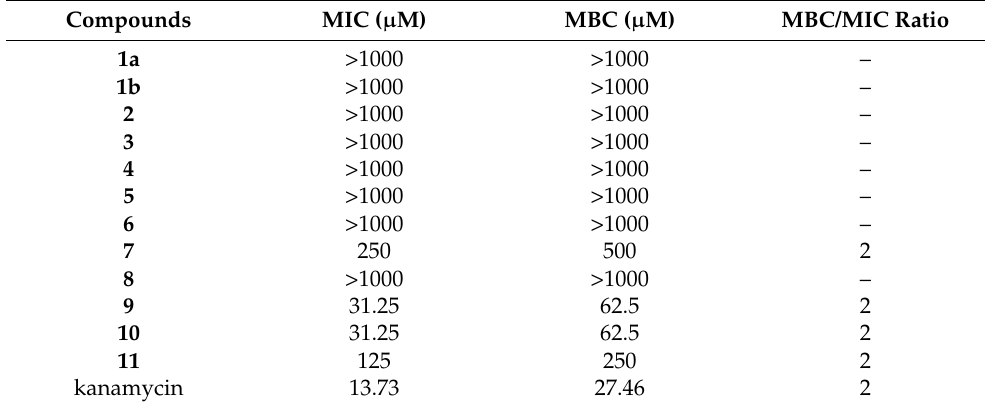
Table 2. The MIC and MBC values of 11 compounds from Hypericum scabrum against C. violaceum ATCC